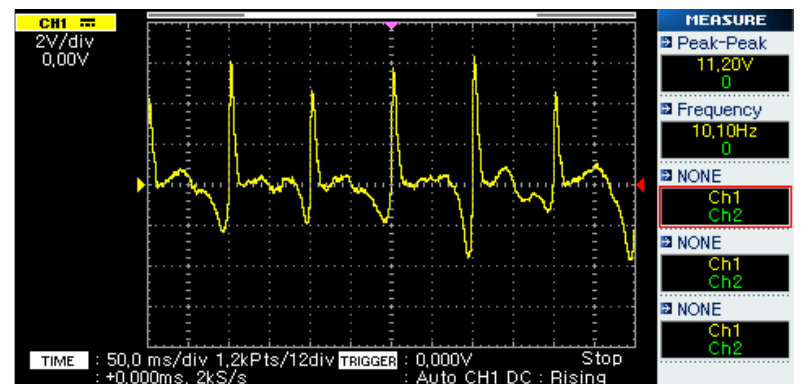
Figure 7. Voltage output of the microgenerator.